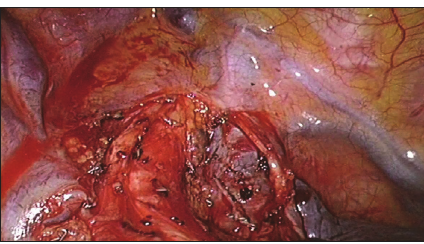
Figure 3: A complete resection of the venous mass was performed.